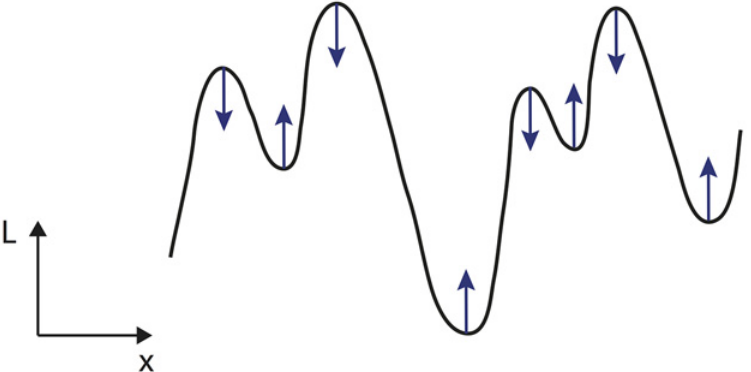
Fig 1. Illustration of the notion of non-enhancement of local extrema for a 1-D signal. The requirement of non-enhancement of local extrema is a way of restricting the class of possible filtering operations by formalizing the notion that new structures in the signal must not be created with increasing scale, by requiring that the value at a local maximum must not increase with scale and that the value at a local minimum must not decrease. (Figure from Lindeberg